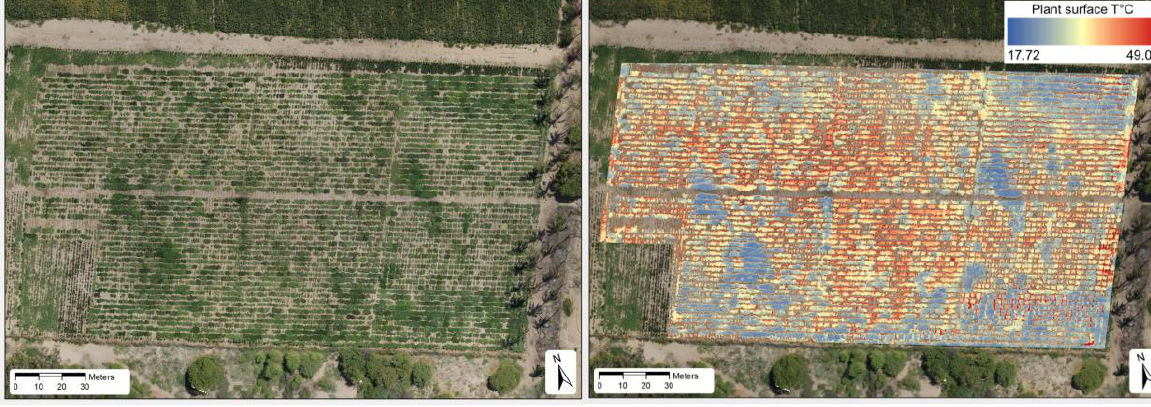
Figure 11: Images of sweet potato plots used to screen for heat tolerance, Piura, Peru 2014. Left: Aerial picture of sweet potato plot in the summer of 2014. Right: UAV-based thermal signatures of plant canopies at midday, 120 dap of the same plot (source: B. Heider, E. Faye, & O. Dangles; pers.